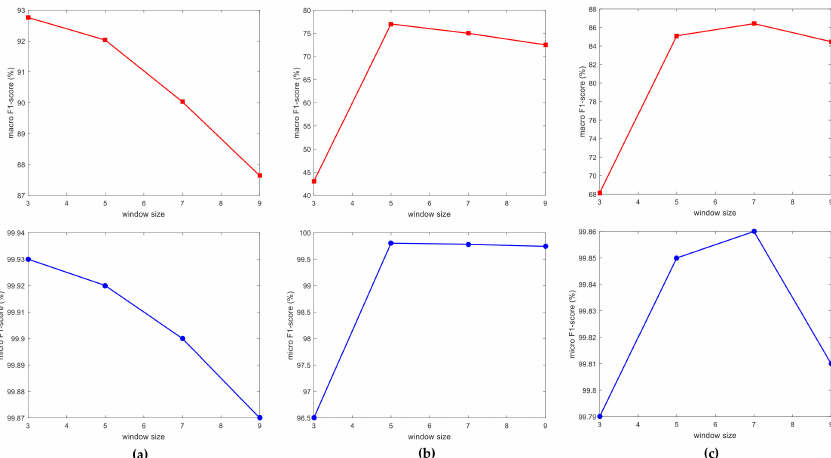
Figure 4. Quantitative results of macro F1-score and micro F1-score for three local statistics-based approaches with di ff erent spatial window sizes (other parameters are fixed): ( a ) The proposed method; ( b ) normalized cut on Kullback–Leibler divergence-based change matrix (NOR_KLD); ( c ) normalized cut on two-sample Kolmogorov-Smirnov test-based change matrix